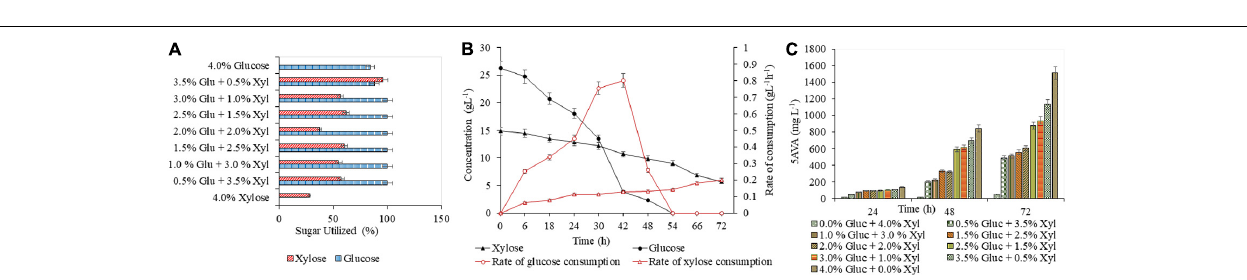
FIGURE 3 | Production of putrescine in CGXII synthetic medium with different blends of glucose and xylose. The percentage utilization of glucose and xylose by PUT Xyl is shown in (A) . The glucose and xylose consumption rate of PUT Xyl is shown in (B) . The time profile of the putrescine production is shown in (C) . Measurements are given as means from triplicates of independent cultivations with standard deviation.